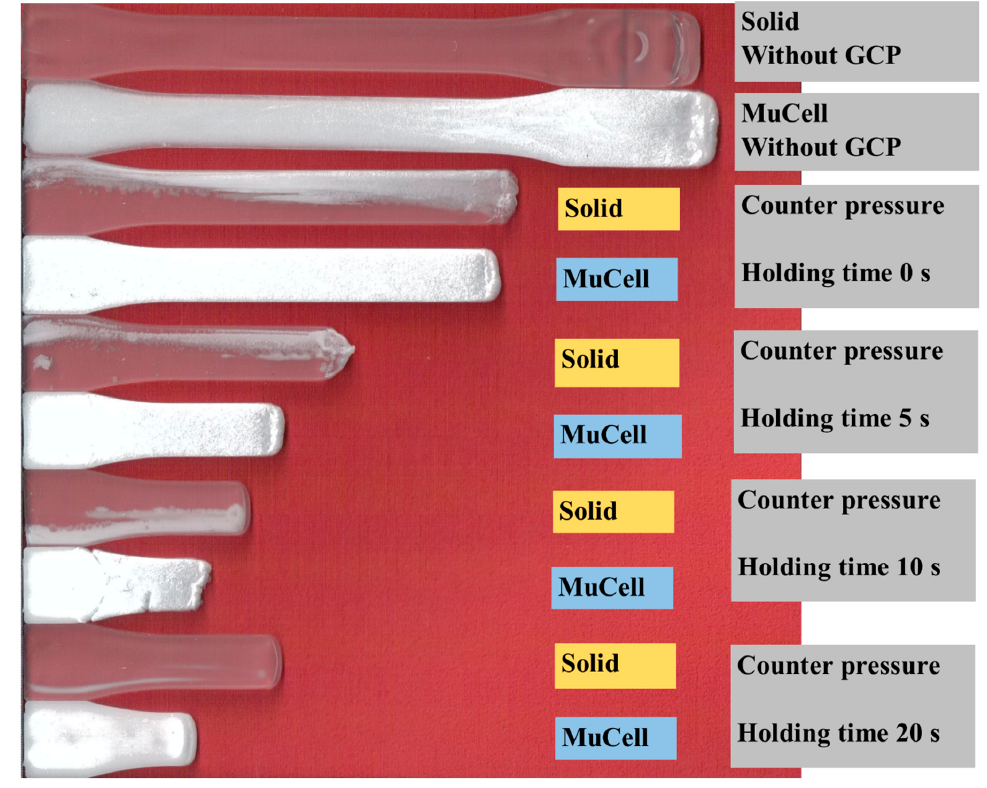
Figure 10. Visual flow length comparison for solid/foam molding with/without GCP.